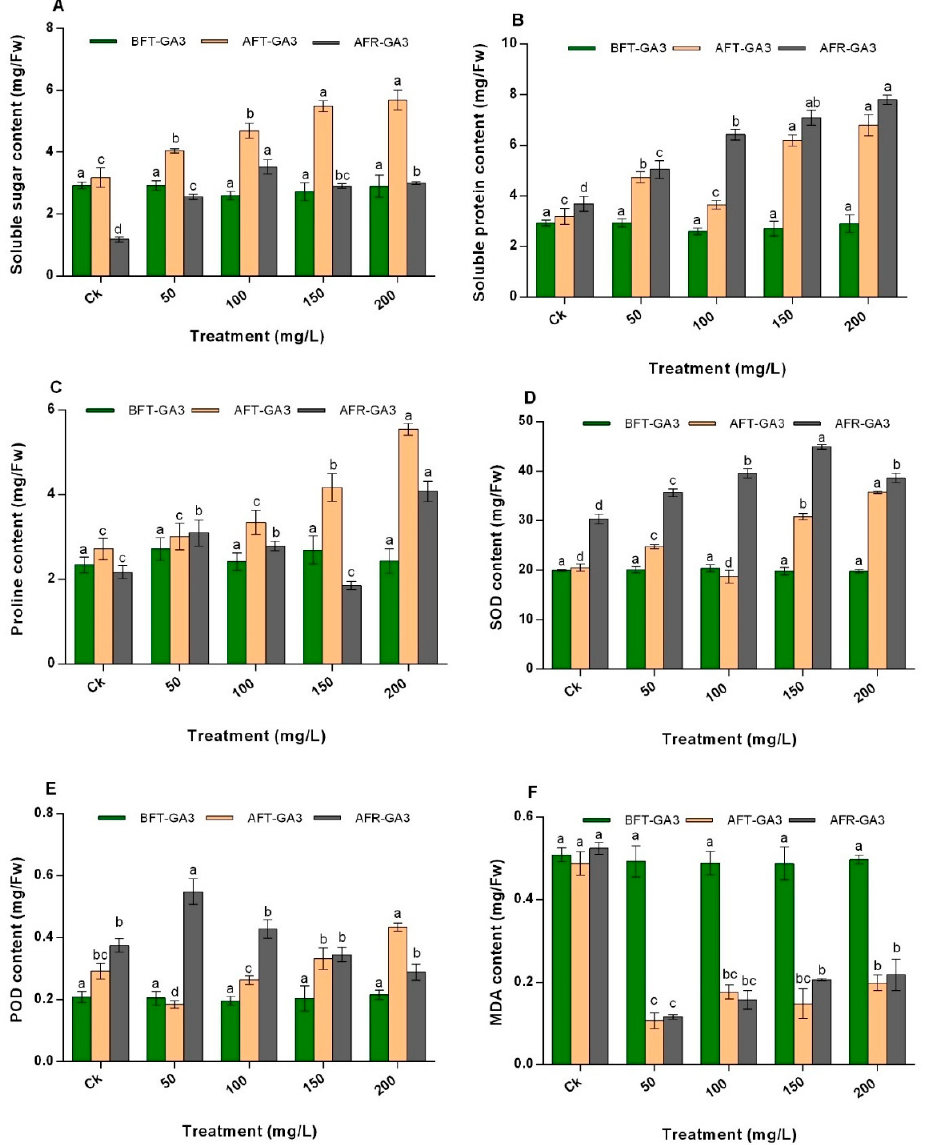
Figure 3. Effect of GA3 on the ( A ) soluble sugar content, ( B ) soluble protein content, ( C ) proline content, ( D ) SOD content, ( E ) POD content, and ( F ) MDA content of N. tangutorum . The values represent the mean of three replicates determinations. The error bars represent standard deviations. Bars with the same letter are not significantly ( p > 0.05) different.